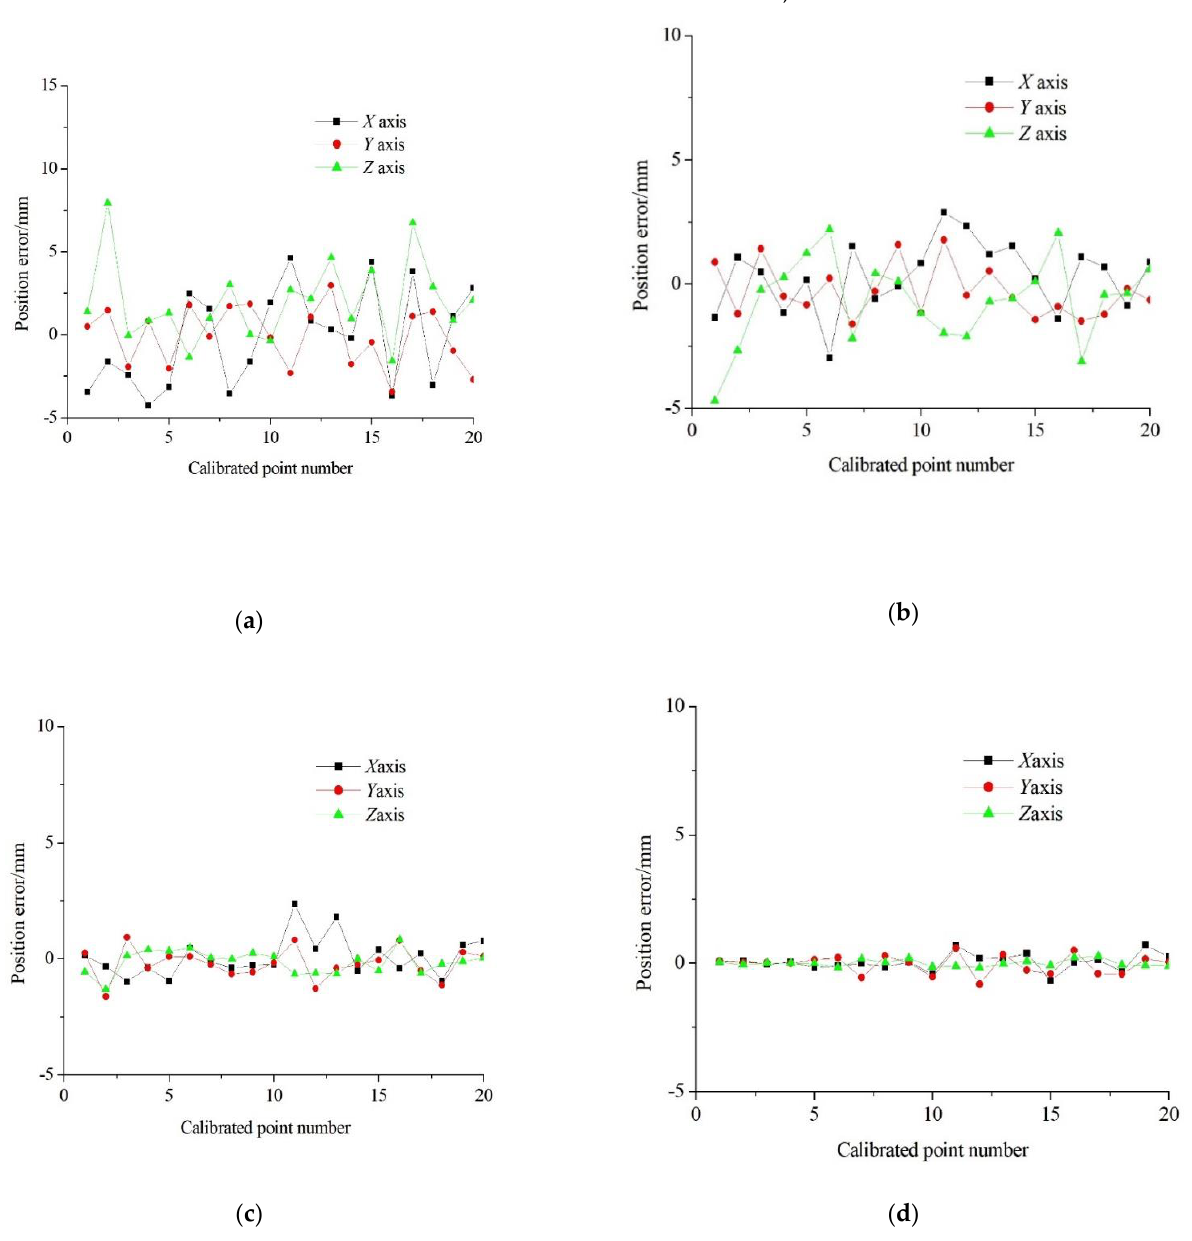
Figure 5. Comparison of error compensation results of each algorithm; ( a ) The error before compen- sation; ( b ) The error after compensation(VSBAS); ( c ) The error after compensation(SFLA); ( d ) The error after compensation(RWSAVSBAS).